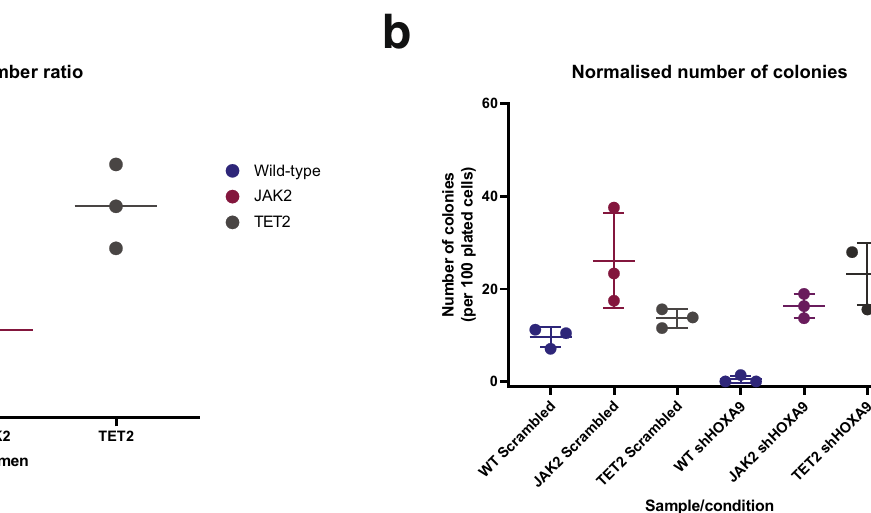
FDR correction indicate a signi fi cant increase of colonies for TET2 mutant versus WT cells with shHOXA9 ð q =0 : 0032 Þ and JAK2 mutant cells in both WT ( q =0 : 0171) and in shHOXA9 ð q =0 : 0171 Þ contexts. Source data are provided as a Source Data fi